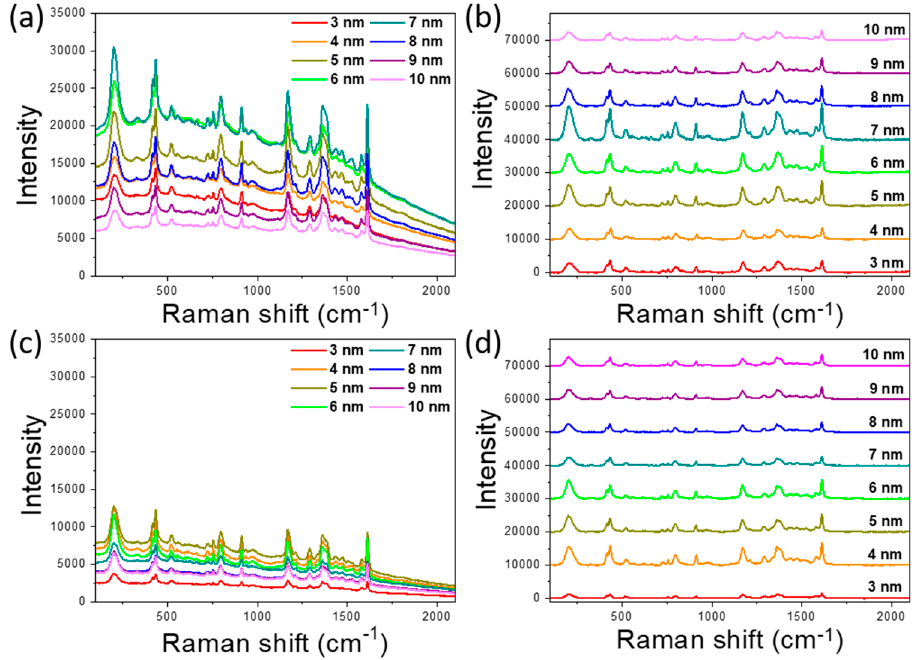
Figure 5. SERS spectra of Crystal Violet (CV) absorbed on the gold films with thicknesses from 3 to 10 nm, deposited on ( a , b ) SiO 2 / Si and ( c , d ) graphene / SiO 2 / Si substrates. ( b , d ) the SERS spectra of CV after subtracting the baseline.